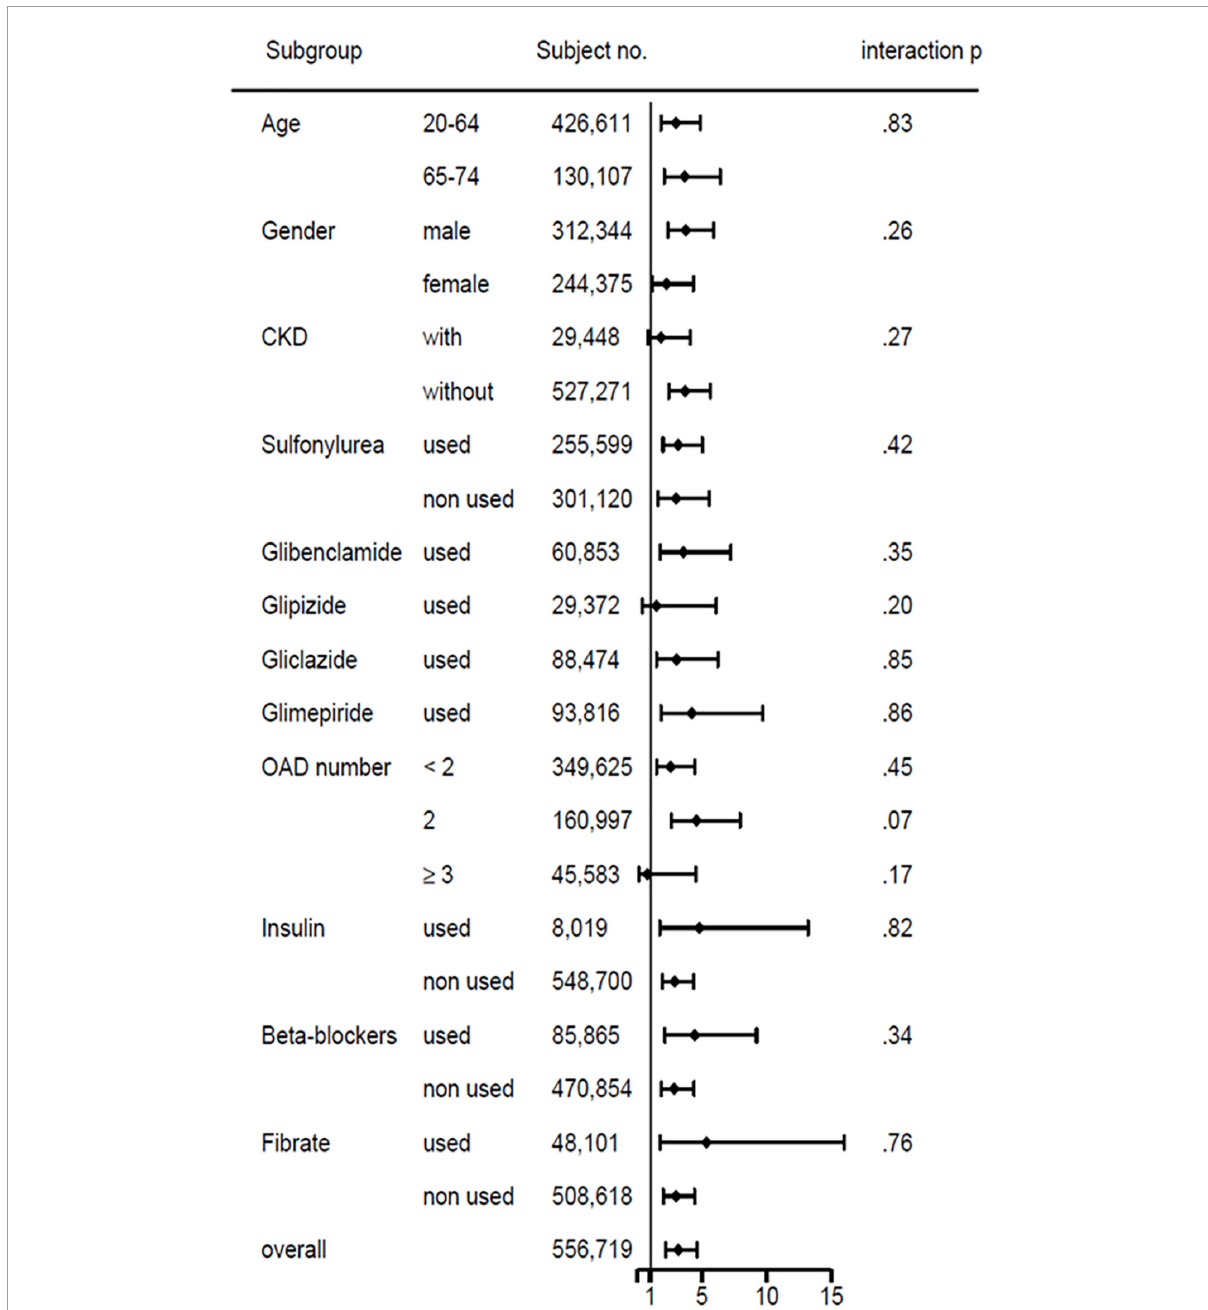
FIGURE4 Subgroup analysis of basic demographics, comorbidity, and medications on hypoglycemia risks in patients with type 2 diabetes with versus without liver